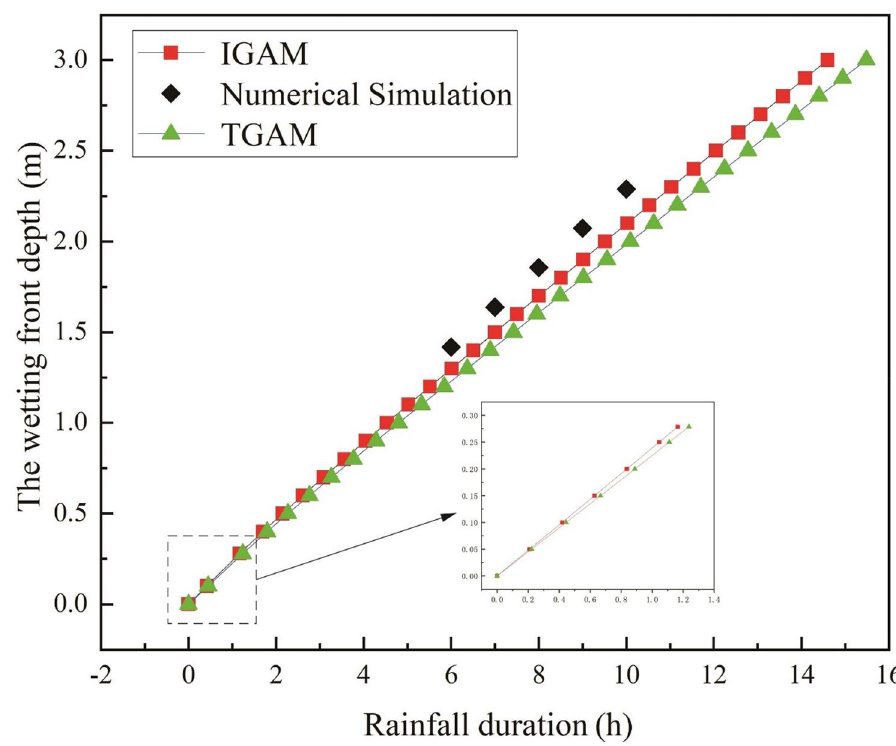
Figure 4. Variation of wetting front depth with rainfall time in different models.